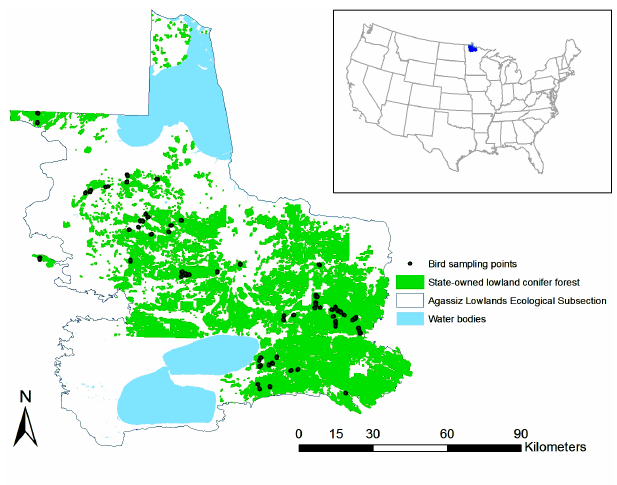
Fig. 1 . Agassiz Lowland Ecological Subsection, state-owned lowland conifer lands, and associated avian point-count locations. Test sample locations and Minnesota Breeding Bird Atlas counts are